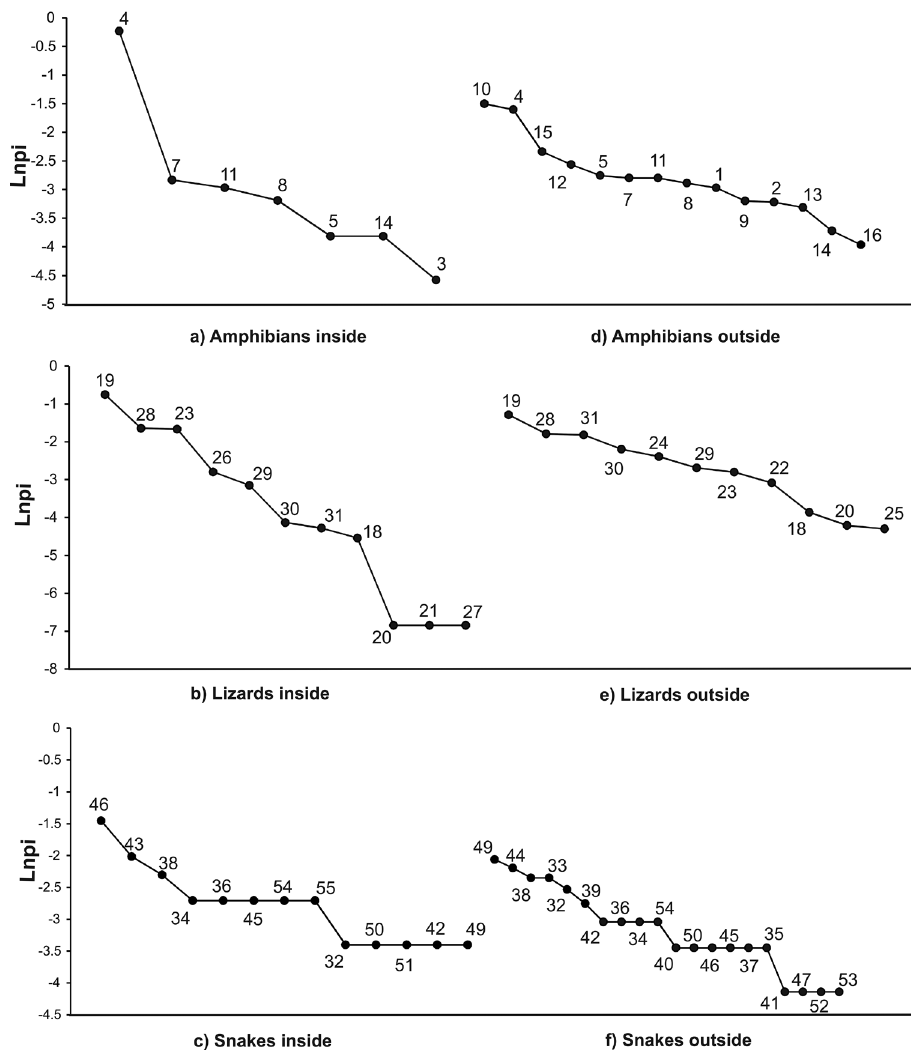
Figure 3. Rank-abundance curves for species of amphibians, lizards, and snakes inside ( a, b, c ), and outside ( d, e, f ) of the REBSSJ. Numbers refers to the acronyms of the species listed in Table 1.